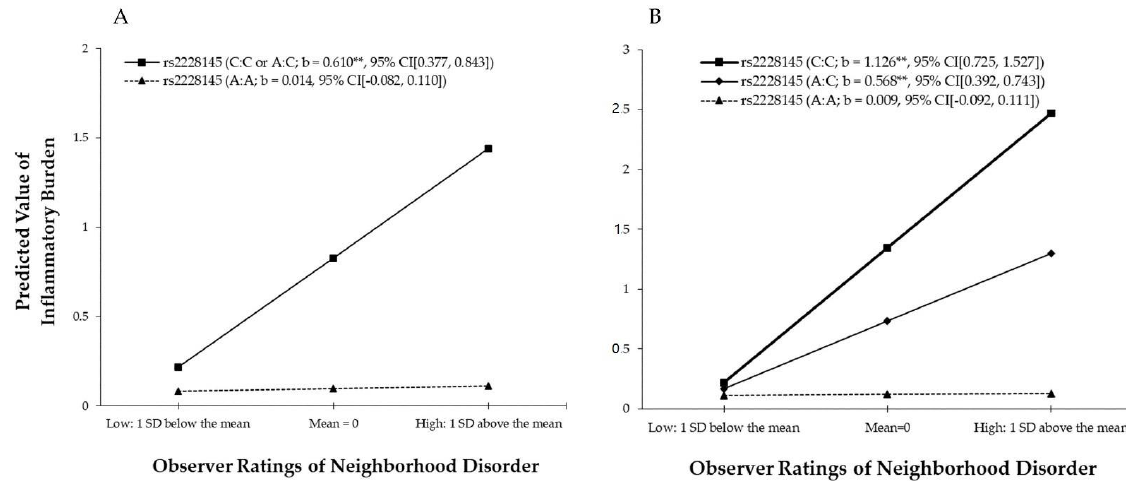
Figure 2. ( A ) The effect of observer ratings of neighborhood disorder on inflammatory burden by rs2228145. ( B ) The effect of observer ratings of neighborhood disorder on the inflammatory burden by rs2228145 (additive coding). Numbers in parentheses refer to simple slopes with 95% confidence intervals. ** p < 0.001.